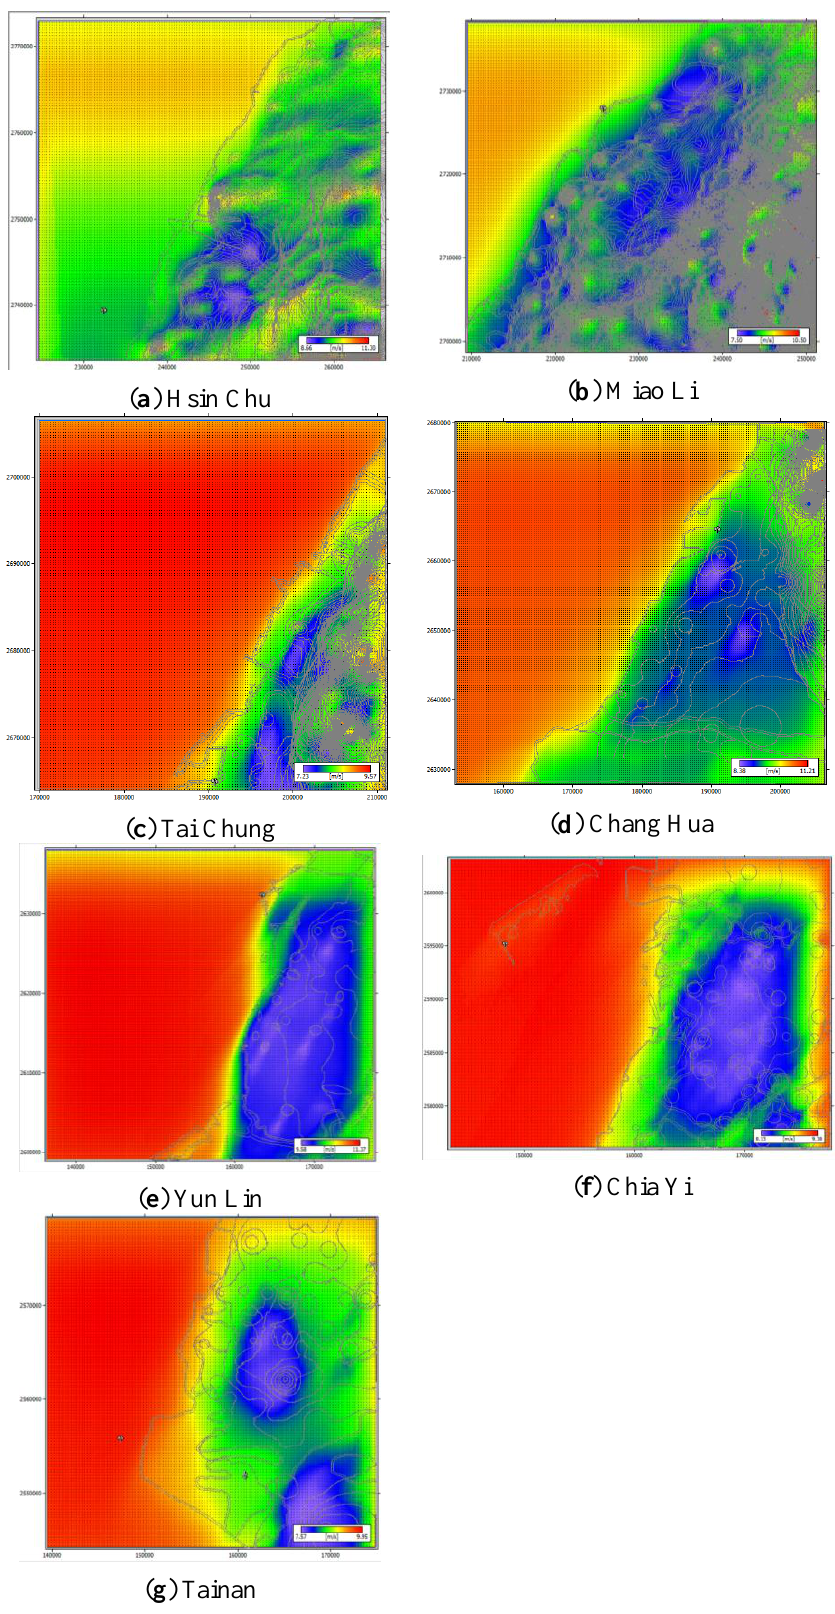
Figure 9. Wind speed distribution diagram of bankable wind farm areas in west Taiwan (at 100